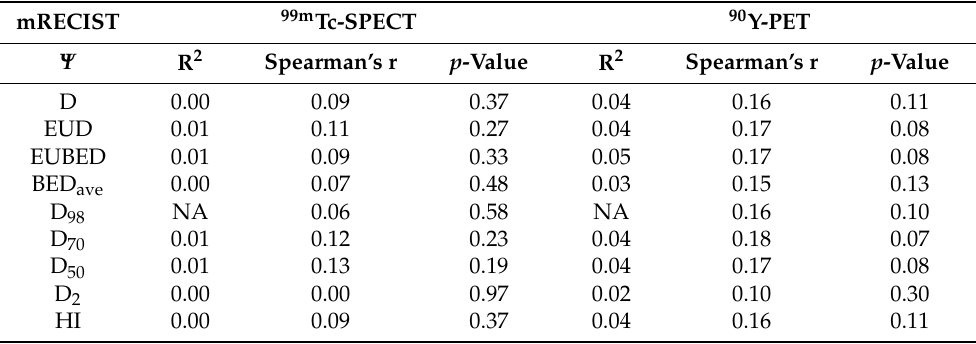
Figure 1. Correlation between mean absorbed dose D and response. The poor correlation can be visually noted. Given a dose value, largely different kind of response were observed, with both methods. Table 3. R 2 , Spearman’s r, and p -values obtained with the 99m Tc-SPECT and 90 Y-PET data for the Ψ –mRECIST response correlation evaluation (Equation